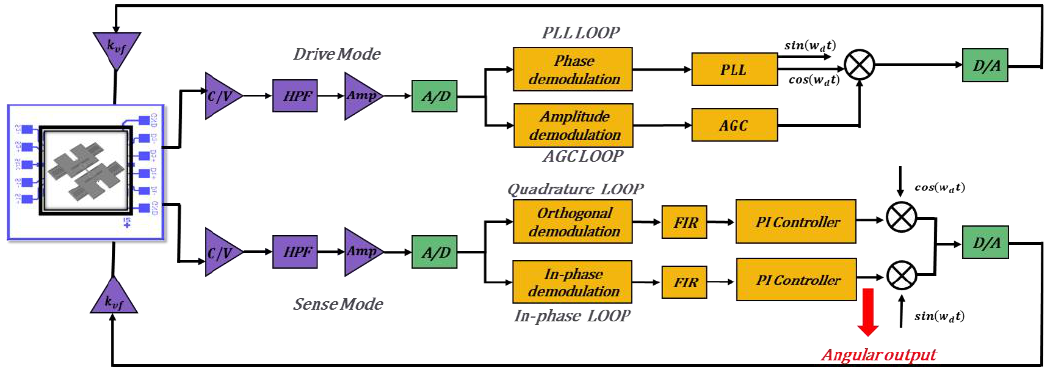
Figure 7. A schematic depiction of the control circuit system for BFVG.